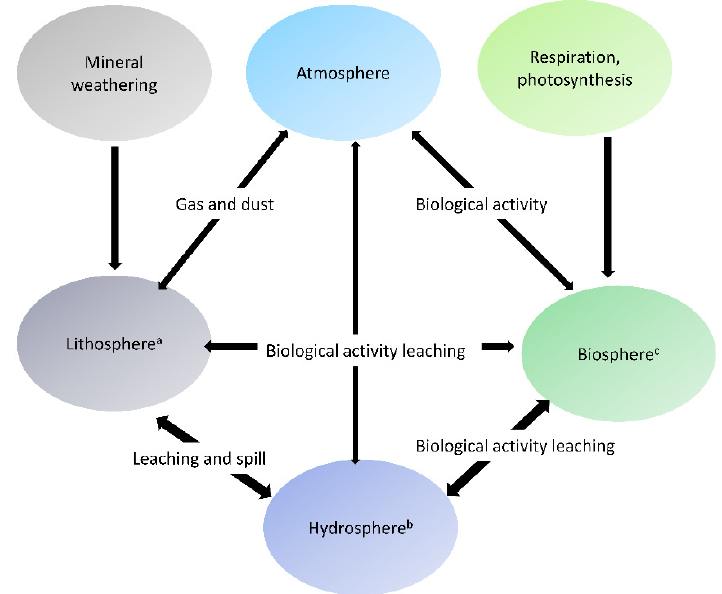
Figure 9. Arsenic cycle and leaching process (adapted from [116,117]). (a) Earth, crust, minerals, soil, sediments, agricultural waste, and industrial waste; (b) Surface water and groundwater; (c) Plants, animals, humans, and microorganisms.